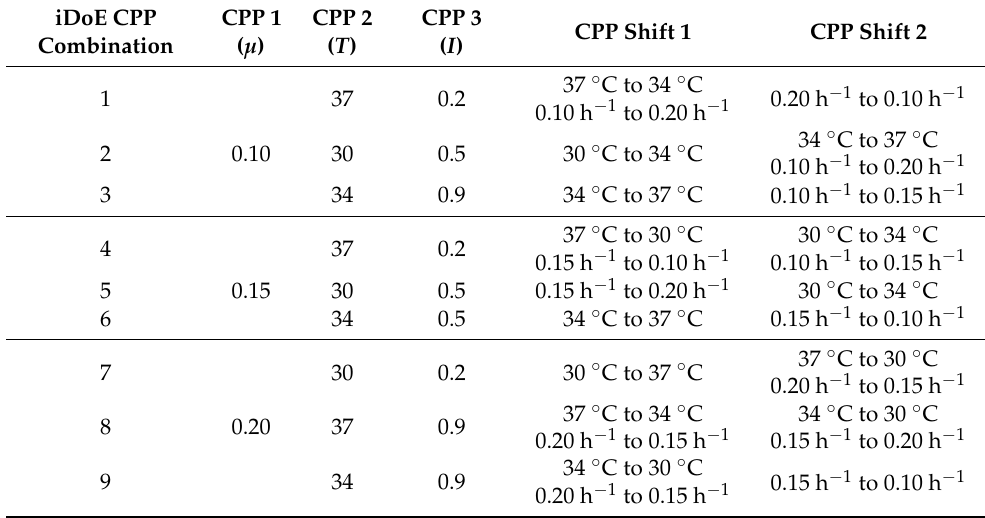
Table A2. CPP combinations of the intensified experiments for the model-based DoE